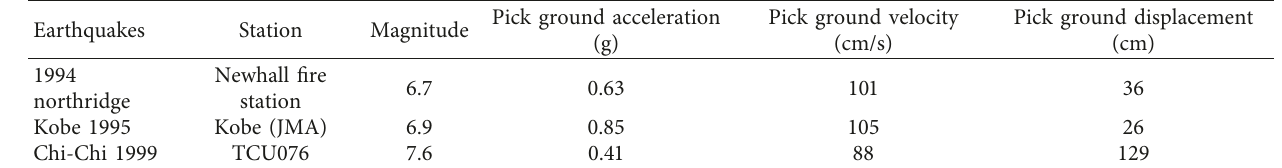
Figure 12: Bridge configurations [22]. Numbers 1, 2, and 3 in the name of bridges (for example b213), respectively, represent short (2.8m), medium (5.6m), and tall (8.4m) piers. The length of span in all bridges is 20m. Table 3: Summary of earthquake ground motions.